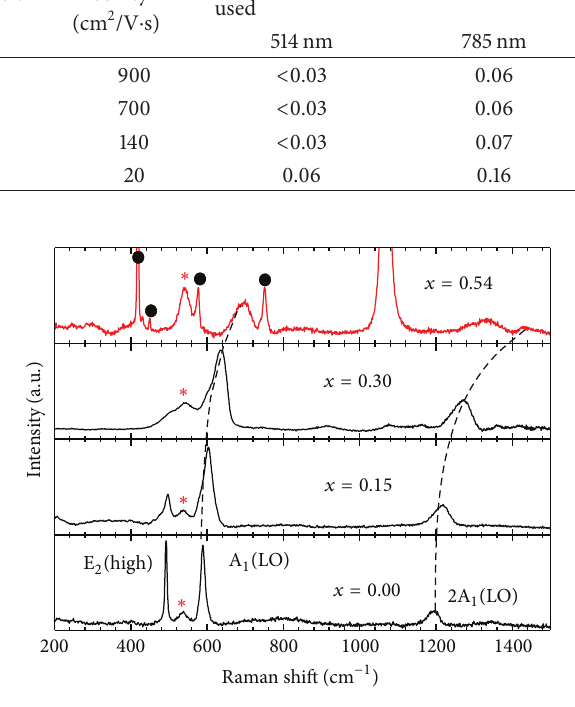
Figure 1: Raman spectra of In 1−𝑥 Ga 𝑥 N ( 𝑥 = 0, 0.15, 0.30, and 0.54) thin films using red laser excitation source (785 nm = 1.58eV). The dashed lines are guides to eyes tracing variation of A 1 (LO) and its replica 2A 1 (LO) mode with increasing Ga atomic fraction. The asterisk (red) indicates the A 1 (TO) GaN mode, and circles show the sapphire modes observed in In 0.46 Ga 0.54 N thin films (colored